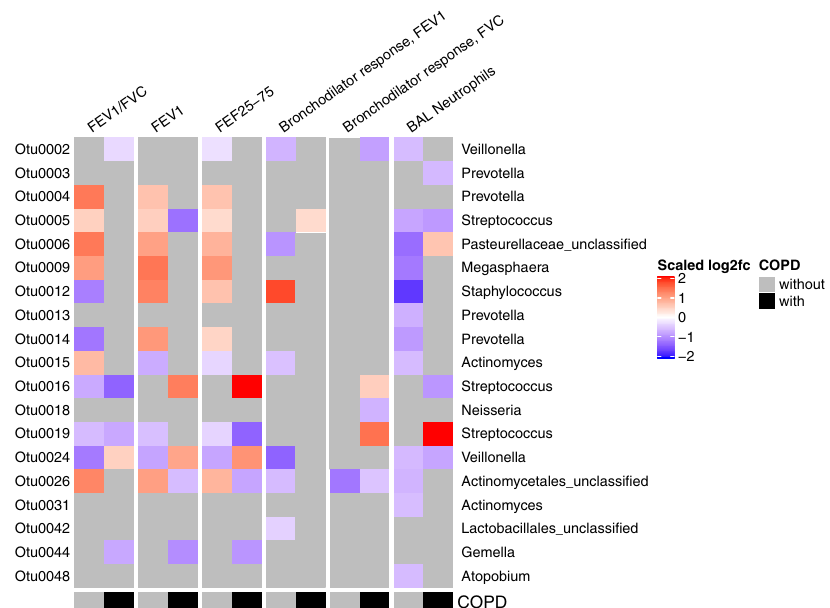
Fig. 5 Heatmap summarizing results of DESeq analysis showing lung bacterial taxa signi fi cantly associated ( q -value < 0.10) with measures of lung function, symptoms (CAT score), and percentage of BAL neutrophils. Further information is provided in Supplementary Table